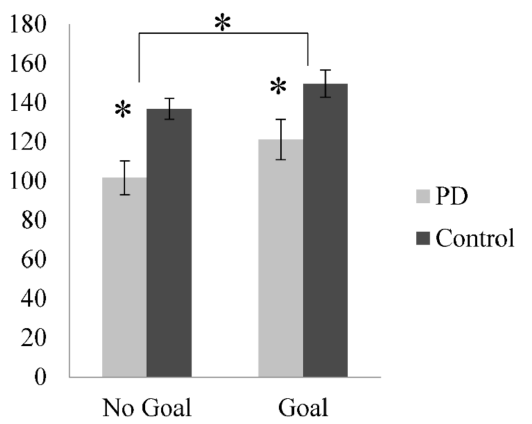
Figure 1. Speech rate (wpm) for Parkinson’s disease (PD) patients and healthy controls on the complex scene description task according to Goal condition; * p <